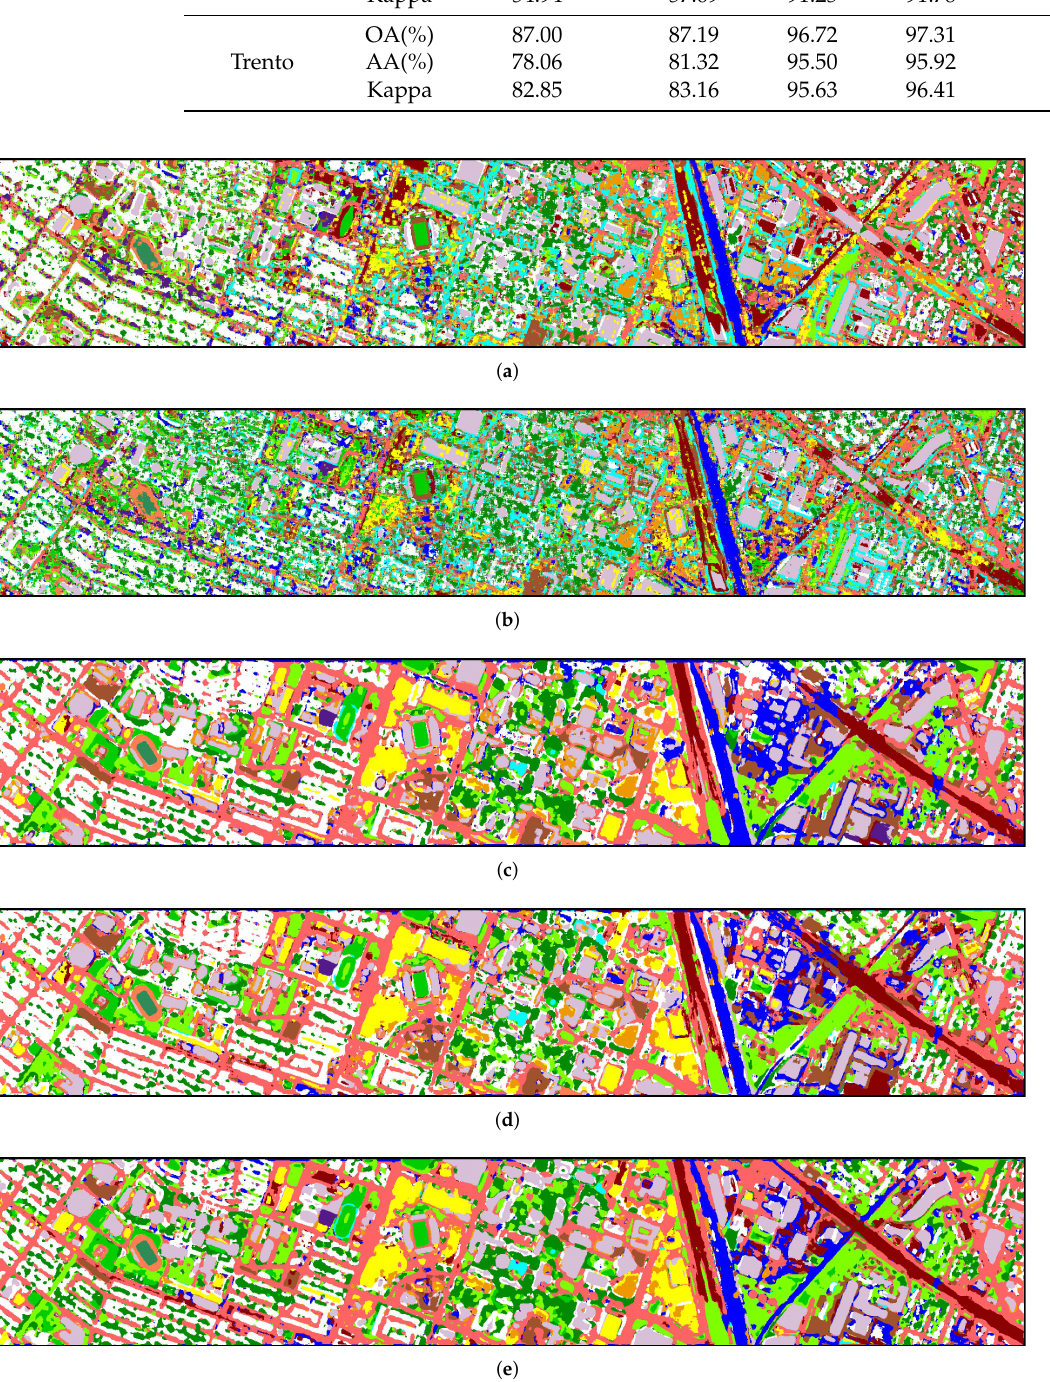
Figure 7. Visualization of the influence of PC 2 A module on 2012 Houston data set. ( a ) LiDAR. ( b ) LiDAR-PC 2 A. ( c ) HSI. ( d ) HSI-PC 2 A. ( e ) PC 2